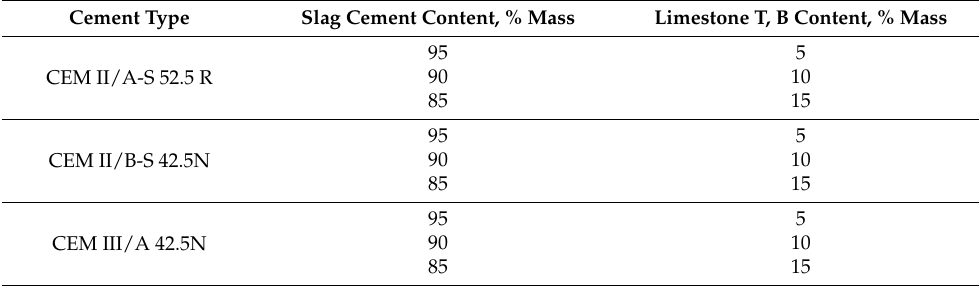
Table 5. Composition of slag-limestone cements used in the